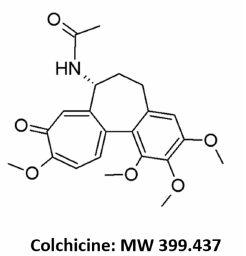
Figure 1. Chemical structure of